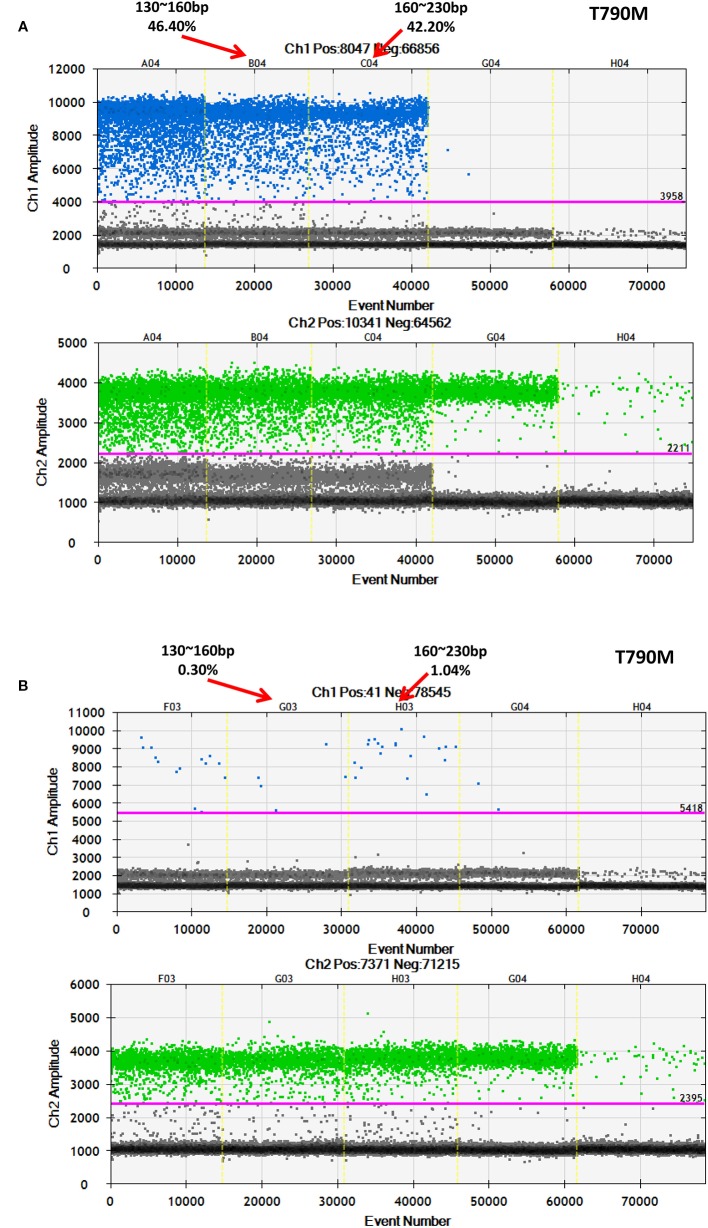
Further validation of an association between fragment size and frequency using ddPCR. Examination of different fragment size libraries from a patient with (A) a high EGFR-T790M frequency (44.53%) and from a patient with (B) a low EGFR-T790M frequency (0.54%) using ddPCR.